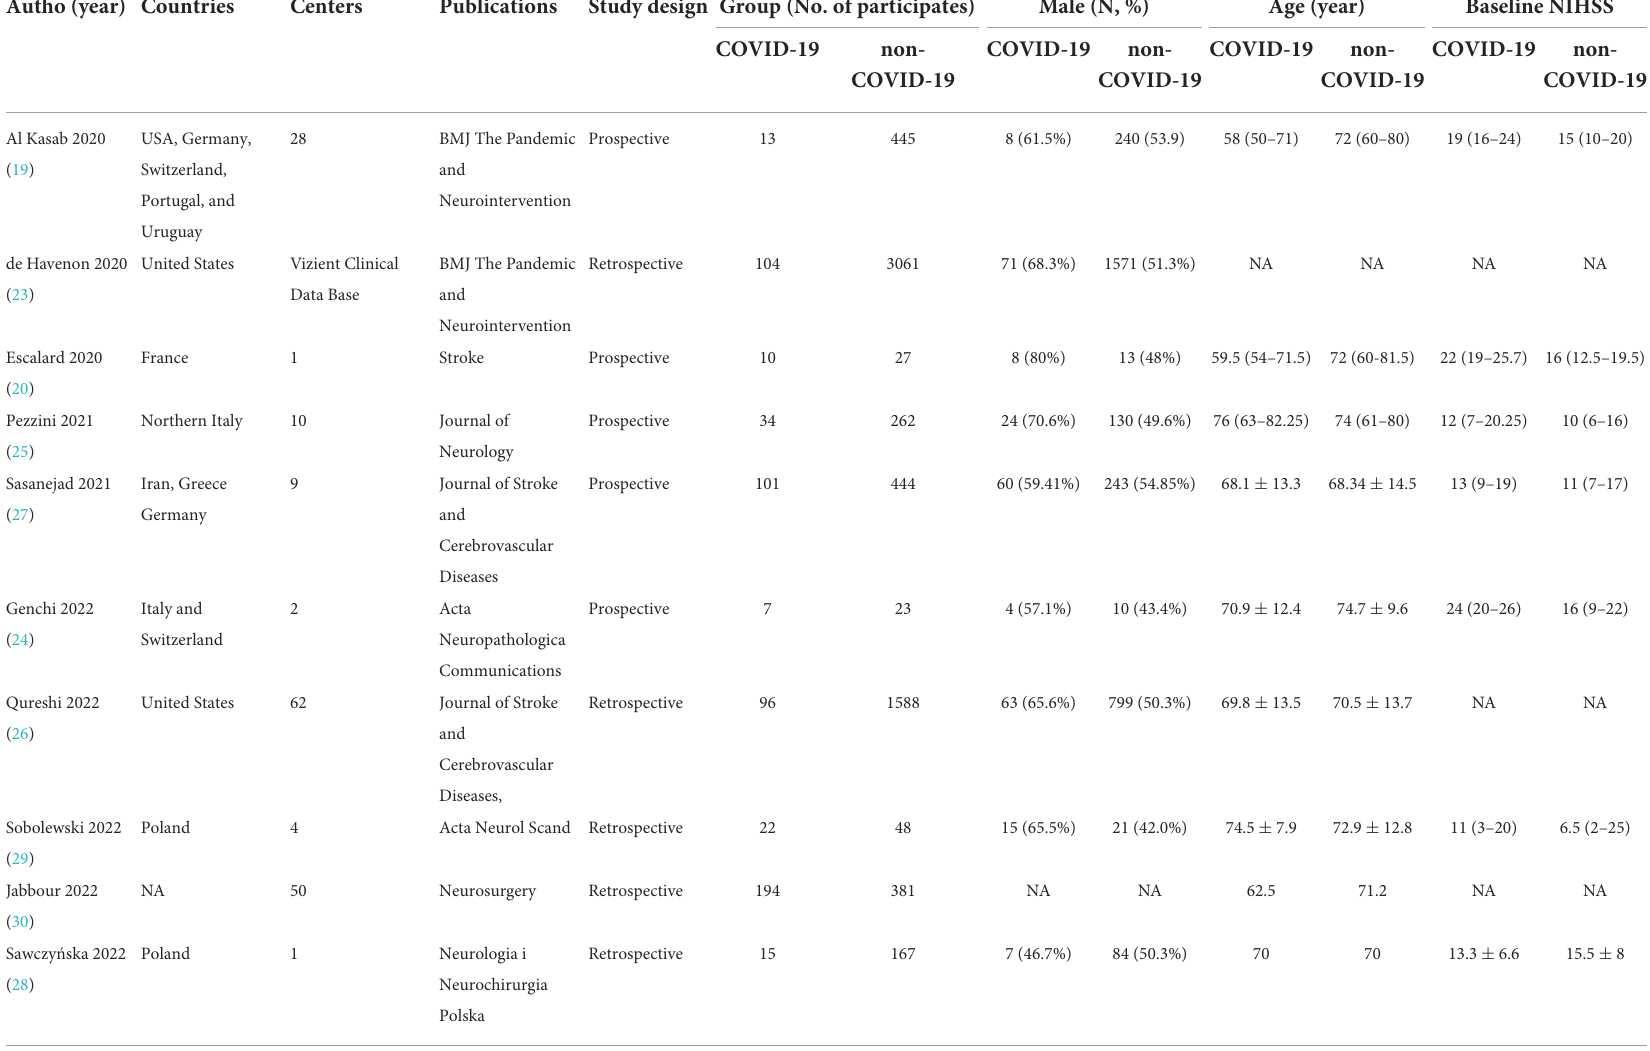
TABLE 1 Characteristics of the included